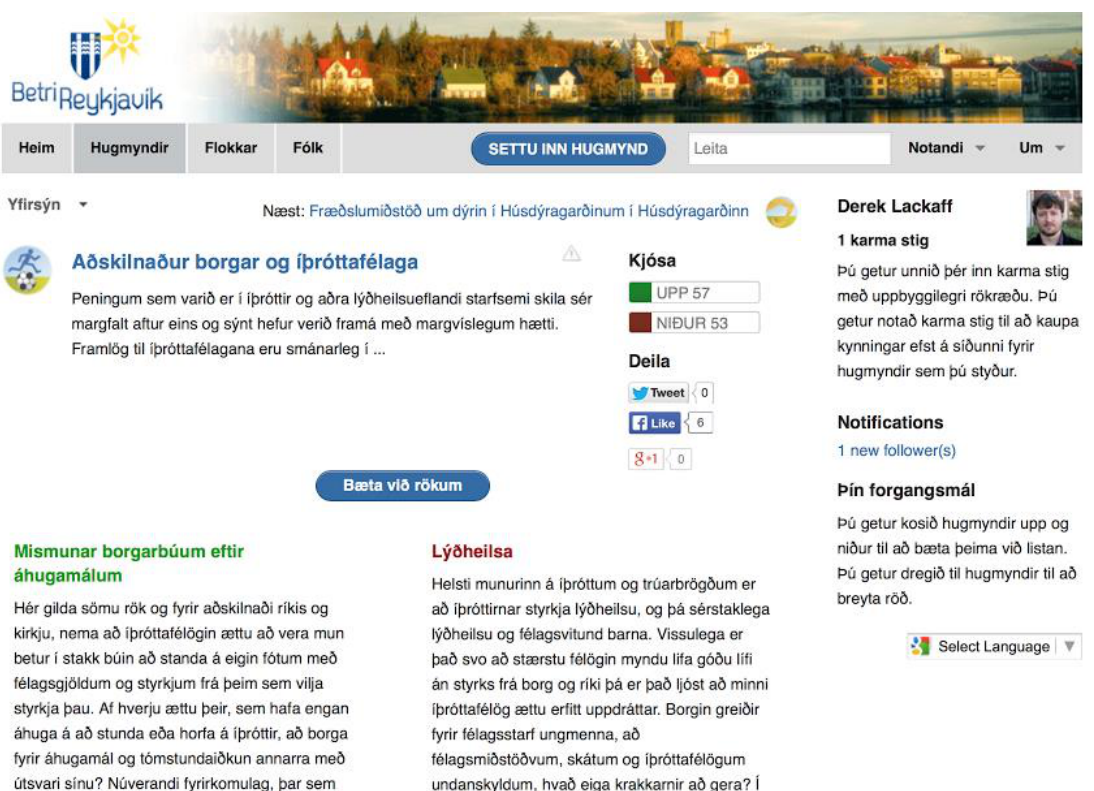
Figure 1. Example of idea on Better Reykjavik, with "pro" and "con" points